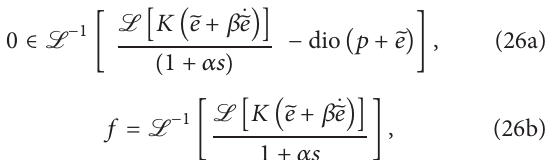
Figure 4: A physical interpretation of ((21a) and